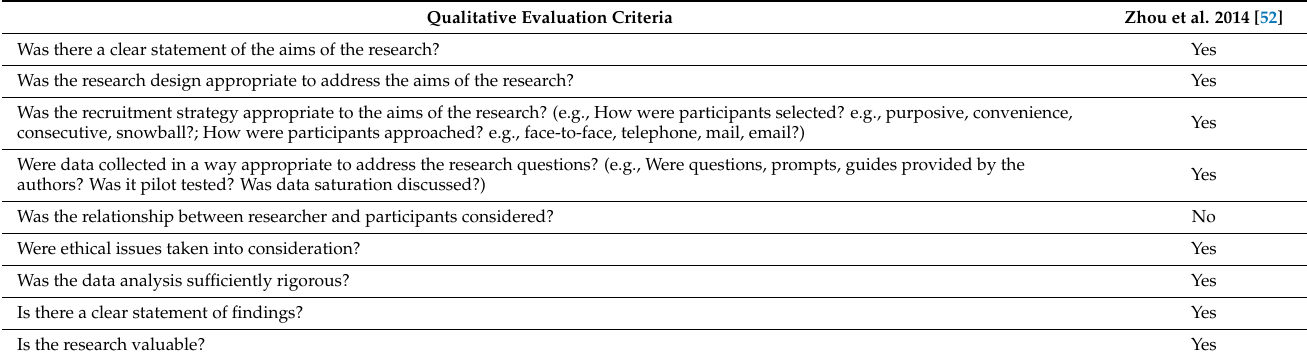
Table 2. Methodological assessment of the qualitative study included in the integrative review (n = 1).